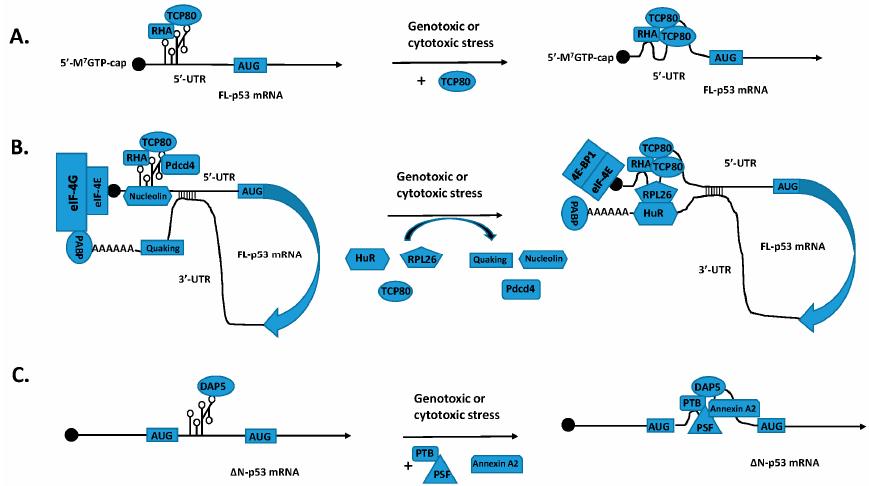
Figure 1. Regulation of full-length p53 mRNA (FL-p53 mRNA) and Δ N-p53 mRNA translation by their internal ribosome entry site (IRES) sequences following geno- and cytotoxic stress. ( A ) A schematic representation showing regulation of p53 IRES activity by translational control protein 80 (TCP80) and RNA helicase A (RHA). During the basal conditions, the secondary structure of the p53 IRES is stabilized and has limited translational activity, partly due to the inadequate interaction between TCP80/RHA and the p53 IRES. Following DNA damage and other cellular stress, increased binding of TCP80 to the p53 IRES and enhanced interaction between TCP80/RHA and the p53 IRES facilitates the unwinding of the secondary structure of the p53 IRES, allowing enhanced translation of the FL-p53 mRNA. ( B ) A putative, comprehensive model of regulation of p53 IRES activity by both its IRES-trans acting factors (ITAFs) and 3 ′ -untranslated region (UTR) binding proteins. During the basal conditions, the secondary structure of the p53 IRES is stabilized and has limited translational activity, due to its binding of several putative negative p53 ITAFs (nucleolin, Pdcd4, and FBL, etc.), inadequate interaction between TCP80/RHA, and the binding of p53 3 ′ -UTR by its negative regulatory proteins, such as Quaking, despite the presence of the cap-dependent translational machinery (eIF-4E, eIF-4G, etc.) and PABP (poly A binding protein) that interacts with eIF-4G. Following DNA damage and other cellular stress, several positive p53 ITAFs (RPL26, TCP80, heterogeneous nuclear ribonucleoprotein (hnRNP) Q, etc.) have displaced negative ITAFs bound to p53 IRES. These positive ITAFs bind to the p53 IRES and facilitate the unwinding of its secondary structure, resulting in enhanced translation of the FL-p53 mRNA. The unwinding of the p53 IRES secondary structure is also assisted by interaction between positive p53 ITAFs and other positive regulatory proteins, such as HuR, that are bound to the p53 3 ′ -UTR after displacing Quaking in response to geno- or cytotoxic stress. The circulation of 5 ′ - and 3 ′ -UTR of the FL-p53 mRNA is stabilized by this interaction, despite disruption of the binding between eIF-4E and eIF-4G by increased amounts of 4E-BP1 following DNA damage and other cellular stress. ( C ) A diagram illustrating regulation of Δ N-p53 IRES activity by its positive ITAFs. During the basal conditions, the secondary structure of the Δ N-p53 IRES is stabilized and has limited translational activity. Following DNA damage and other cellular stress, PTB translocates from nuclear to the cytoplasm, binding of PTB/PSF and Annexin A2 to the IRES of Δ N-p53 mRNA facilitates the unwinding of the secondary structure of the Δ N-p53 IRES, resulting in increased translation of the Δ N-p53 mRNA.